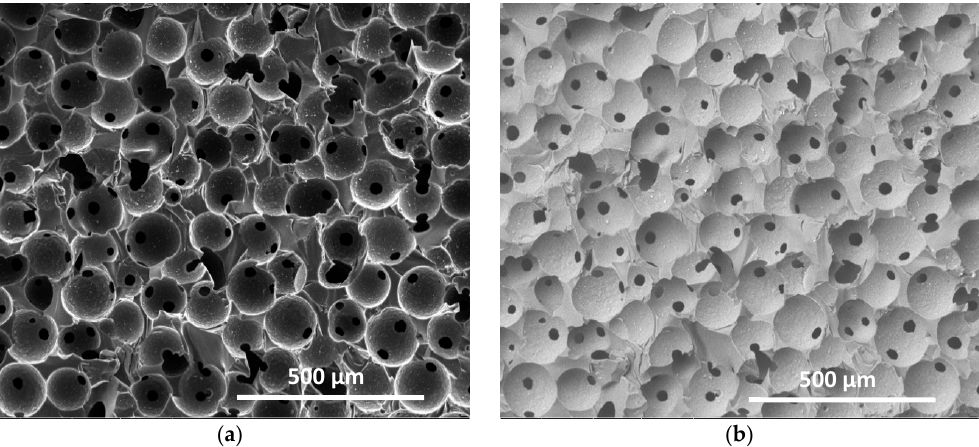
Figure 1. Scanning electron microscopy (SEM) pictures of the CFR250 sample: ( a ) with secondary electrons (SE) detector; ( b ) with backscattered electrons (BSE) detector. Images of type ( a ) and ( b ) were used for measuring cell sizes and window sizes, respectively.